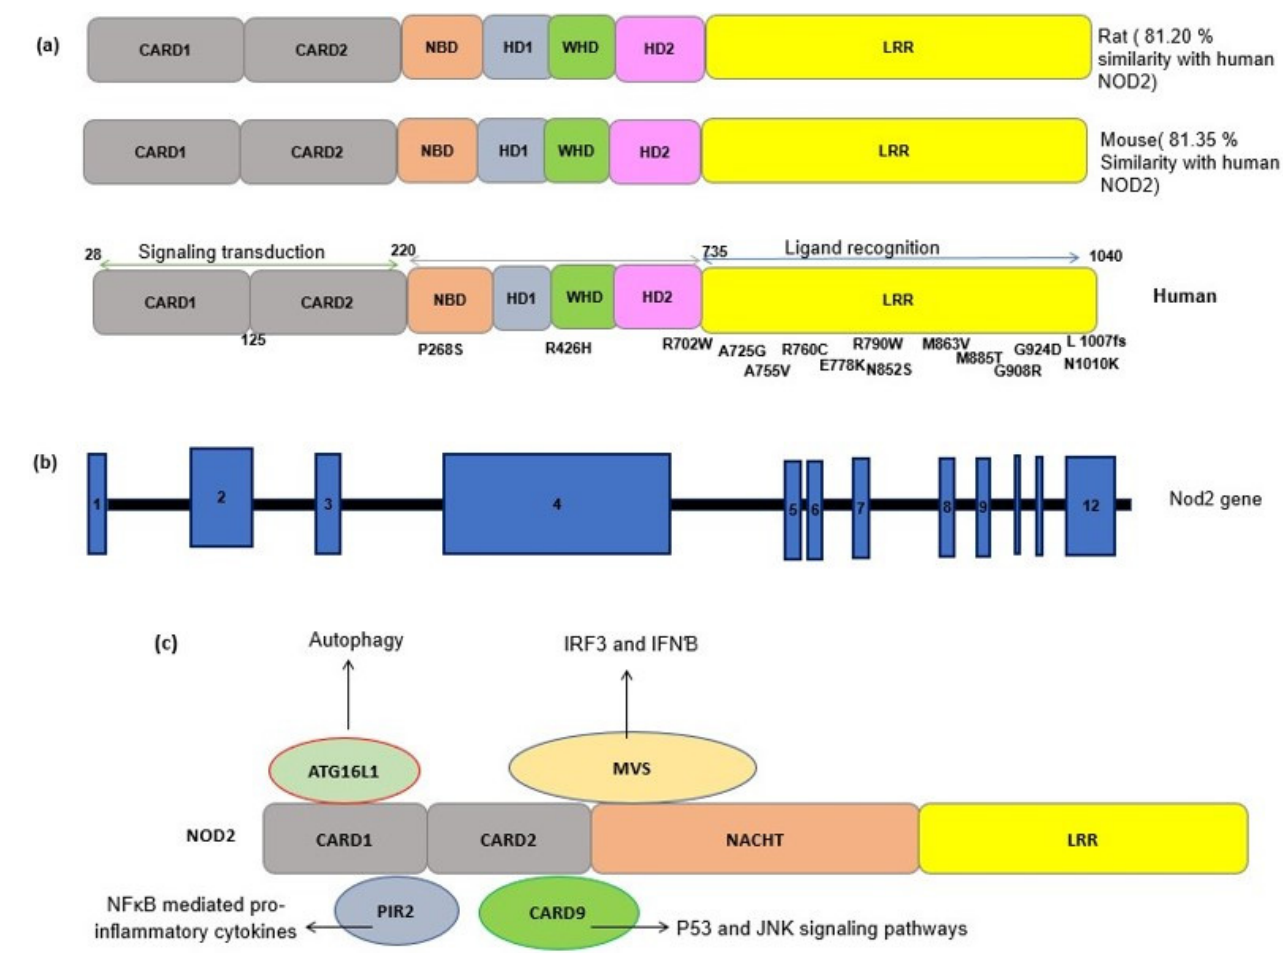
Figure 1. ( a ) Schematic representation of the NOD2 protein structure in a human, a mouse and a rat. The sequence identity of NOD2 gene in the rat and mouse with the human NOD2 gene is estimated by pairwise BLAST [14]. Common SNPs have been shown alongside the protein domains. CARD, caspase recruitment domain; NACHT, nucleoside triphosphates’ (NTPase) domain; LRR, leucine-rich repeats. ( b ) A schematic representation of the NOD2 gene. NOD2 is composed of 12 exons (blue rectangles). The numbers inside the blue rectangles indicate the exon numbers. ( c ) A schematic of the interactions between NOD2 and other cellular proteins. The interaction of activated NOD2 with PIR2 activates the NF-kB pathway. The NOD2 interaction with Autophagy-related 16-like 1 (ATG16L1) induces autophagy machinery assembling. NOD2 interacts with the adapter protein mitochondrial antiviral signaling protein (MAVS) upon sensing ssRNA, active interferon-regulatory factor 3 (IRF3) and consequently production of interferon β (IFN β ).